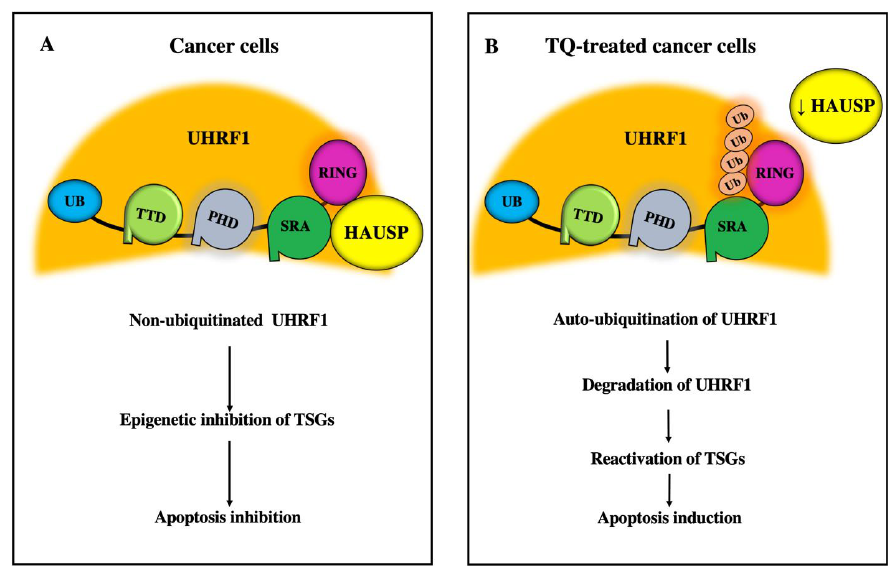
Figure 3. Schematic representation of TQ-induced HAUSP/UHRF1 deregulation and the related events . ( A ). In cancer cells, UHRF1 is protected from degradation through a direct interaction with HAUSP leading to epigenetic inhibition of TSGs which subsequently inhibits apoptosis. ( B ). Exposure of cancer cells to TQ induces a decrease in the expression of HAUSP which allows an autoubiquitination of UHRF1 through its E3 ubiquitin ligase activity as a first step for its degra- dation later inducing the reactivation of TSGs and